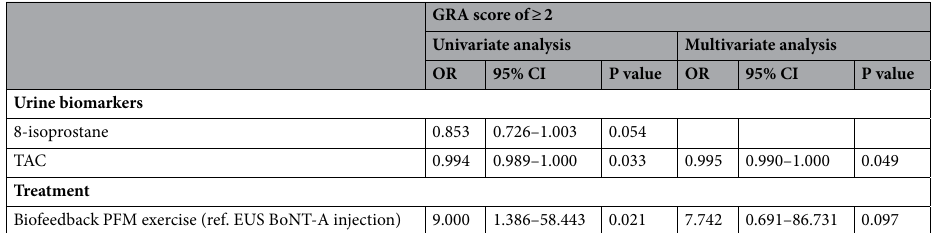
Table 5. Univariate and multivariate logistic regression analyses for predicting successful treatment outcomes in patients with DV. DV Dysfunctional voiding, GRA Global response assessment, TAC Total antioxidant capacity, PFM Pelvic floor muscle, EUS External urethral sphincter, BoNT‑A Botulinum toxin A.